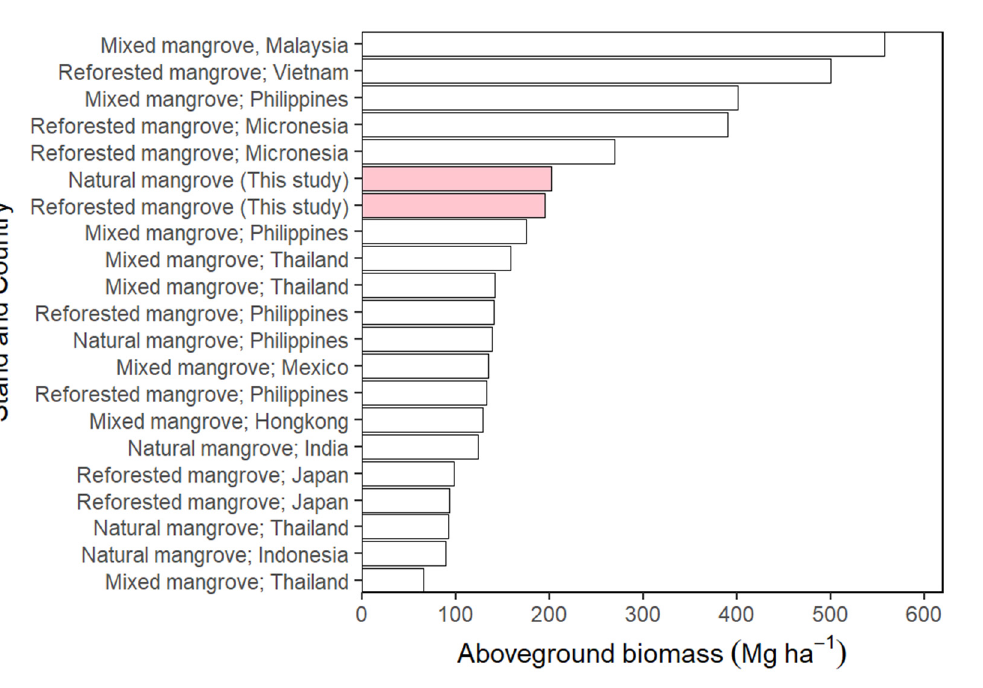
Figure 10. Comparison of studies on mangrove aboveground biomass in the Philippines and other mangrove-rich countries in Asia. These forests include mixed mangrove forests [30,56–60], reforested mangrove forests [8,56,61–63], and natural mangrove forests [8, 64-65].